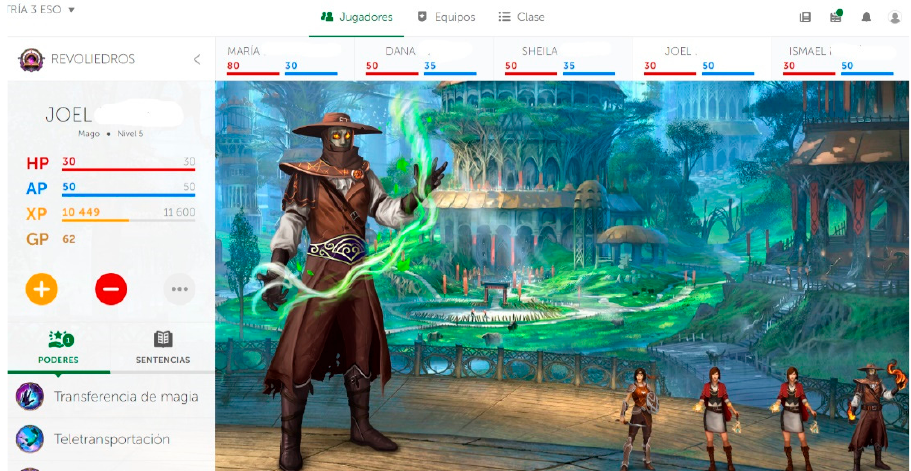
Figure 2. Aesthetics of one cooperative group in Classcraft.